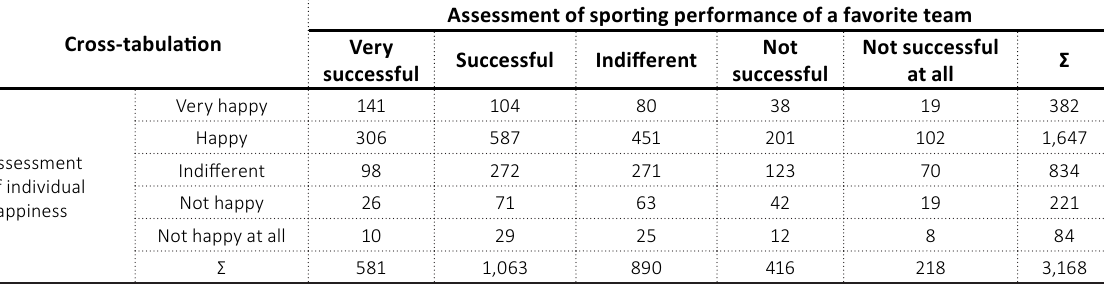
Table 8. Cross-tabulation of assessment of sporting performance and assessment of individual